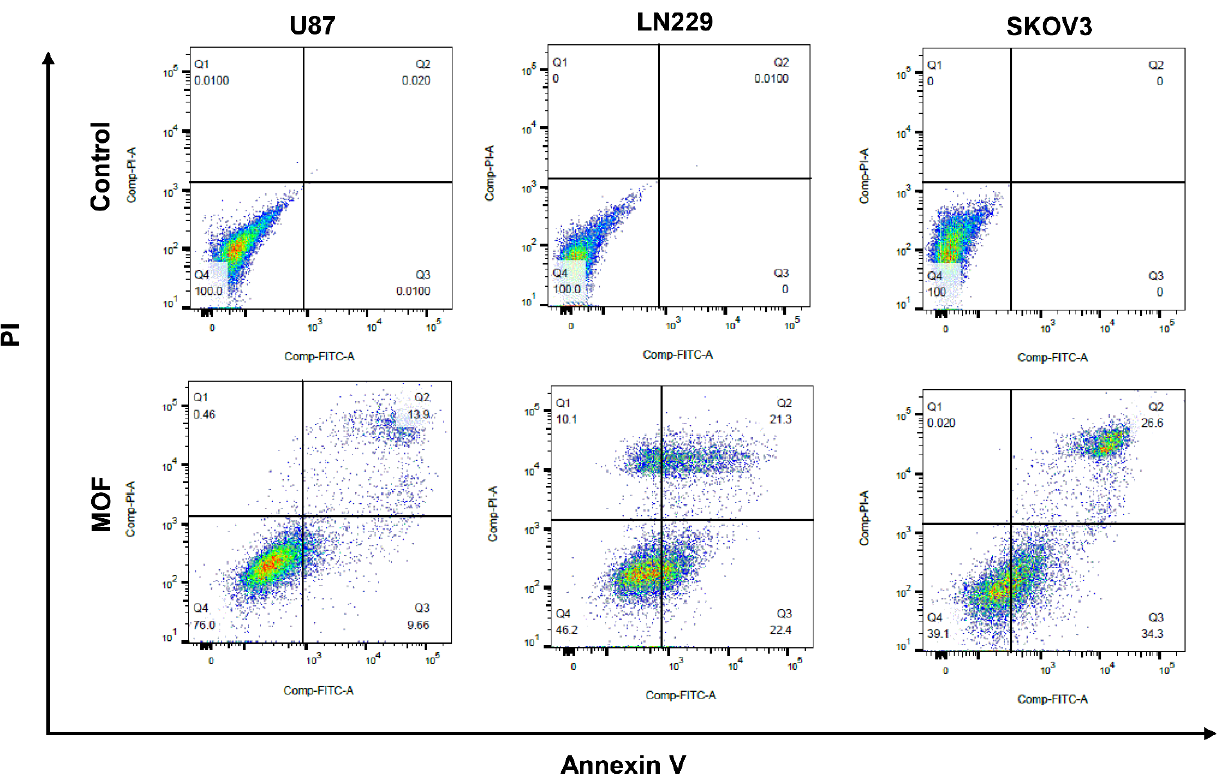
Figure 9. Apoptotic cell death induced by the Cu-MOF in cancer cells; 12.5 µg mL − 1 (IC 50 ) of Cu-MOF.